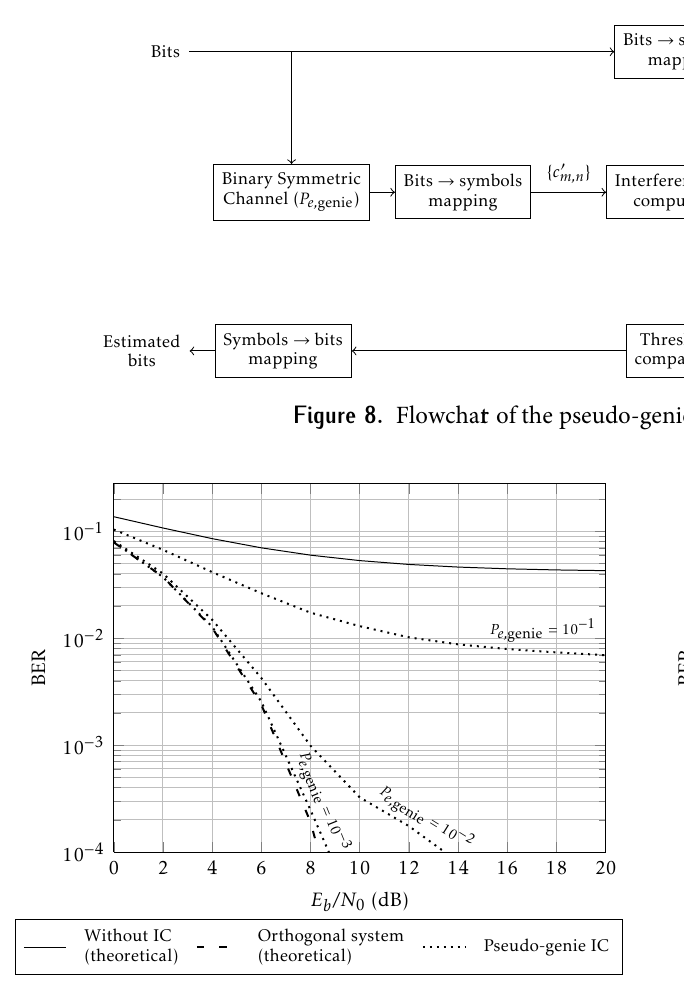
Figure 9. BER as a function of E genie receiver, ρ = 4 / 3 , a TFL generator and P e, genie ∈ { 10 − 1 , 10 − 2 , 10 − 3 } .